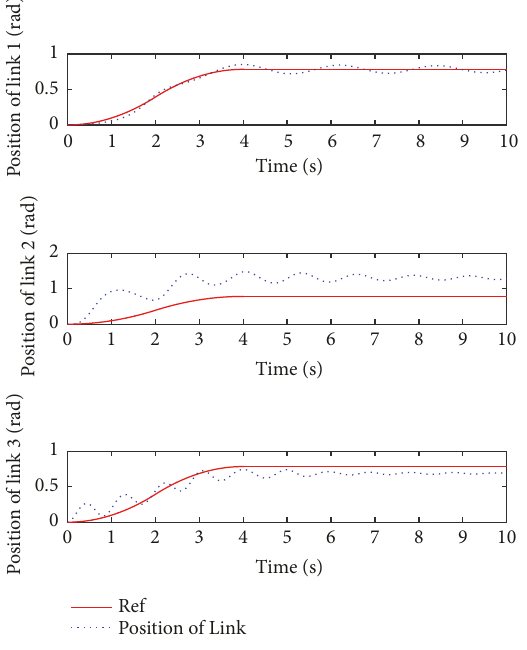
Figure 2: Response of three links.